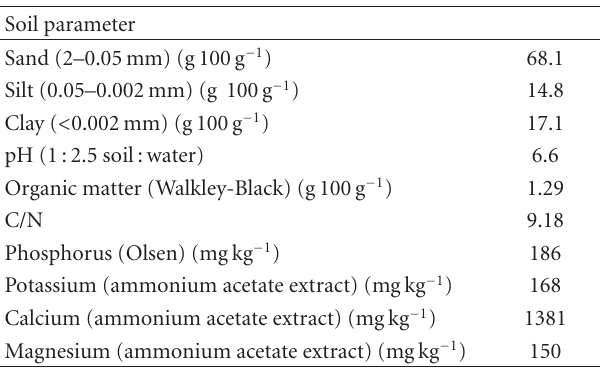
Table 1: Initial soil physical and chemical characteristics in the experimental parcel (year